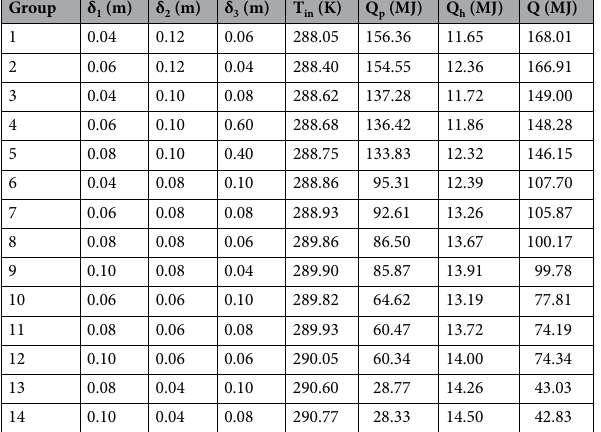
Table 9. Calculation results of different structures. Note: T in Indoor temperature, Q p Heat-storage of porous wall, Q h Heat-storage of thermal storage wall, Q Total heat